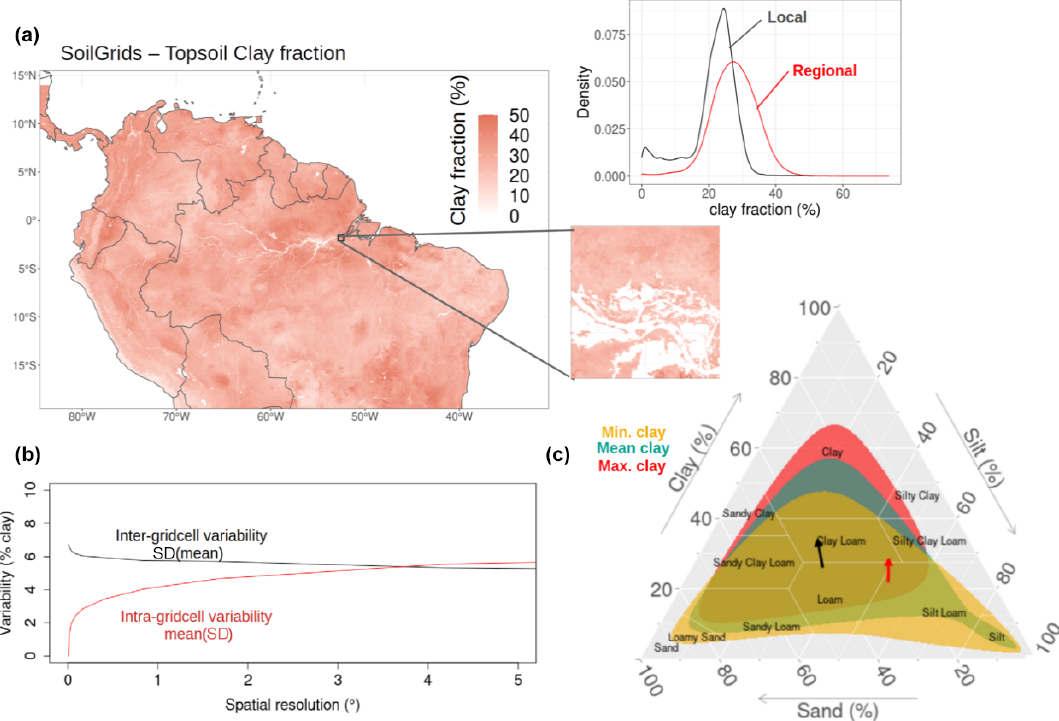
Figure 1. Topsoil (0–5cm) clay fraction spatial distribution as defined by the latest version of SoilGrids with a magnified example of a 1 ◦ × 1 ◦ grid cell (a) . The Min., Mean, and Max. clay scenarios are those soil types that are characterised respectively by the minimum, average, and maximum clay fraction content in each grid cell, excluding those without soil-textural information (for instance the rivers as illustrated in the magnified map). In panel (a) , the density plot reveals the clay fraction distribution at the regional and local (magnified grid cell) levels. Subplot (b) shows both the intra-grid cell (i.e. mean of the standard deviation (SD) of the clay content) and the inter-grid cell (the standard deviation (SD) of the mean clay content) variability as a function of the spatial resolution. Subplot (c) is the resulting soil-texture distribution for each scenario. The arrows in subplot (c) show the average change of soil texture moving from the Min. clay to Mean clay scenario (black) and observed (red) changes in soil texture after deforestation (Eleftheriadis et al.,